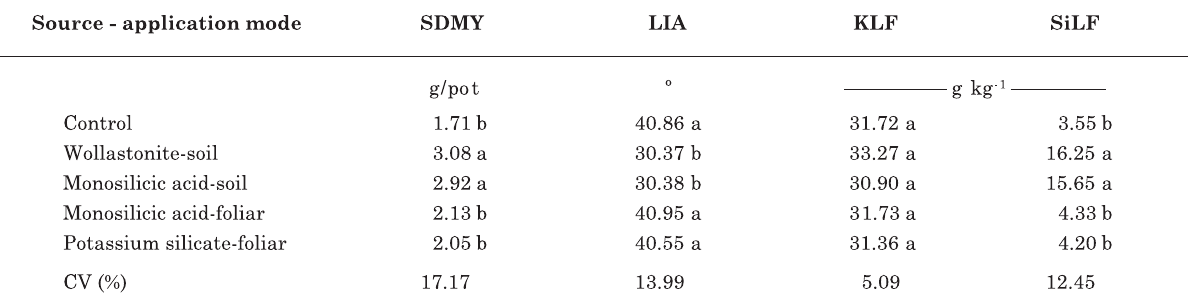
Means followed by the same letter within a column are not significantly different at the 0.05 level by the Tukey